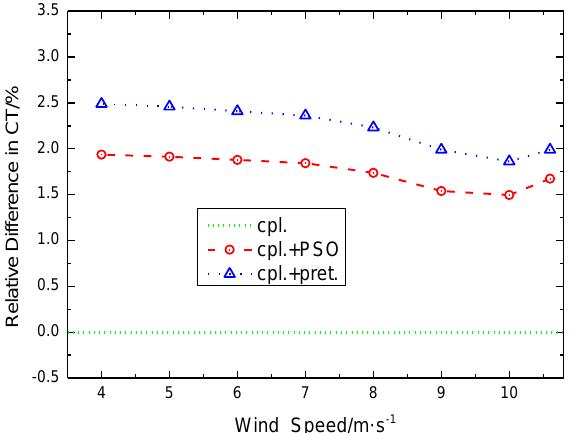
Figure 8. Relative difference in thrust coefficient compared to the cpl. Case.